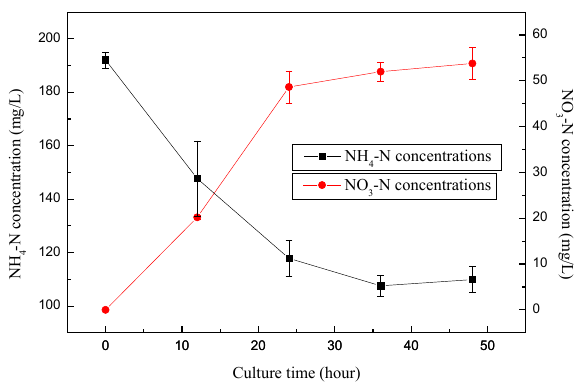
-N removal with time. 4